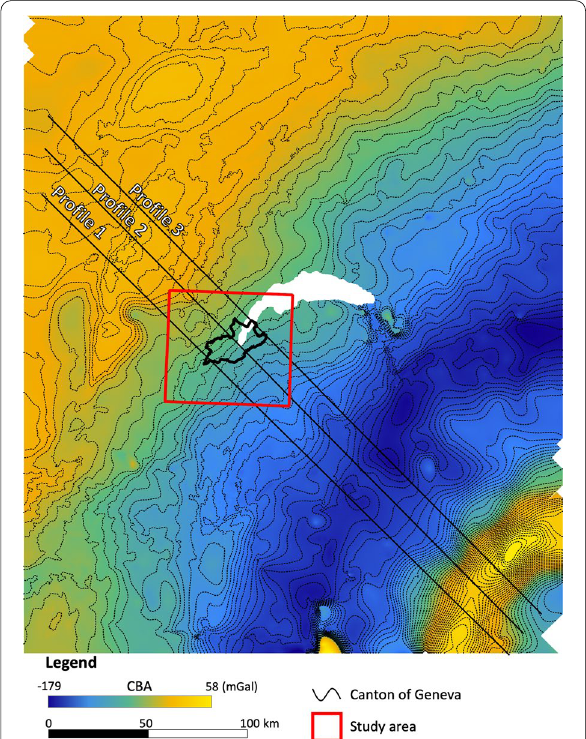
Fig. 9 80 km wavelength low-pass Butterworth filter